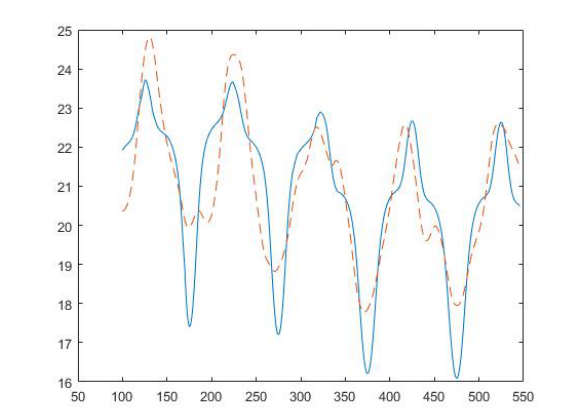
Fig. 23. Trajectory approximation of one of 50 cells using the first 9principal components in geometry A, seeding a.